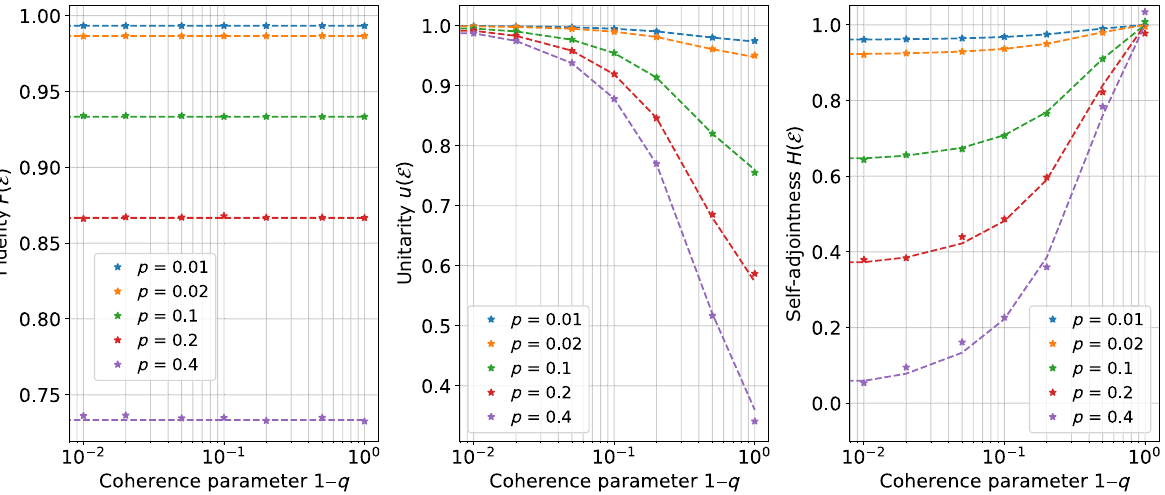
FIG. 2. The estimated values of F ( E 1 ) , u ( E 1 ) , and H ( E 1 ) obtained by 2-RB on one-qubit system for various parameters p and q , where we have taken 5000 samplings both for measurement and for unitary sequences. The dots show the fitting results, and the dashed lines represent theoretical